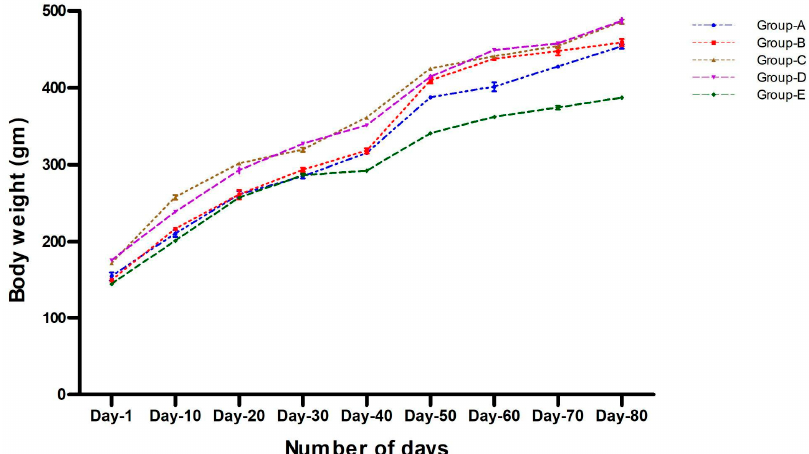
Figure 2. Bodyweight (in grams) of rats in Phase II (recovery period). A significant increase in bodyweight was observed as age increased in all the five experimental groups, whereas there was no significant difference found in the bodyweight of rats on different salt formulations. Data are presented as mean ± SD.